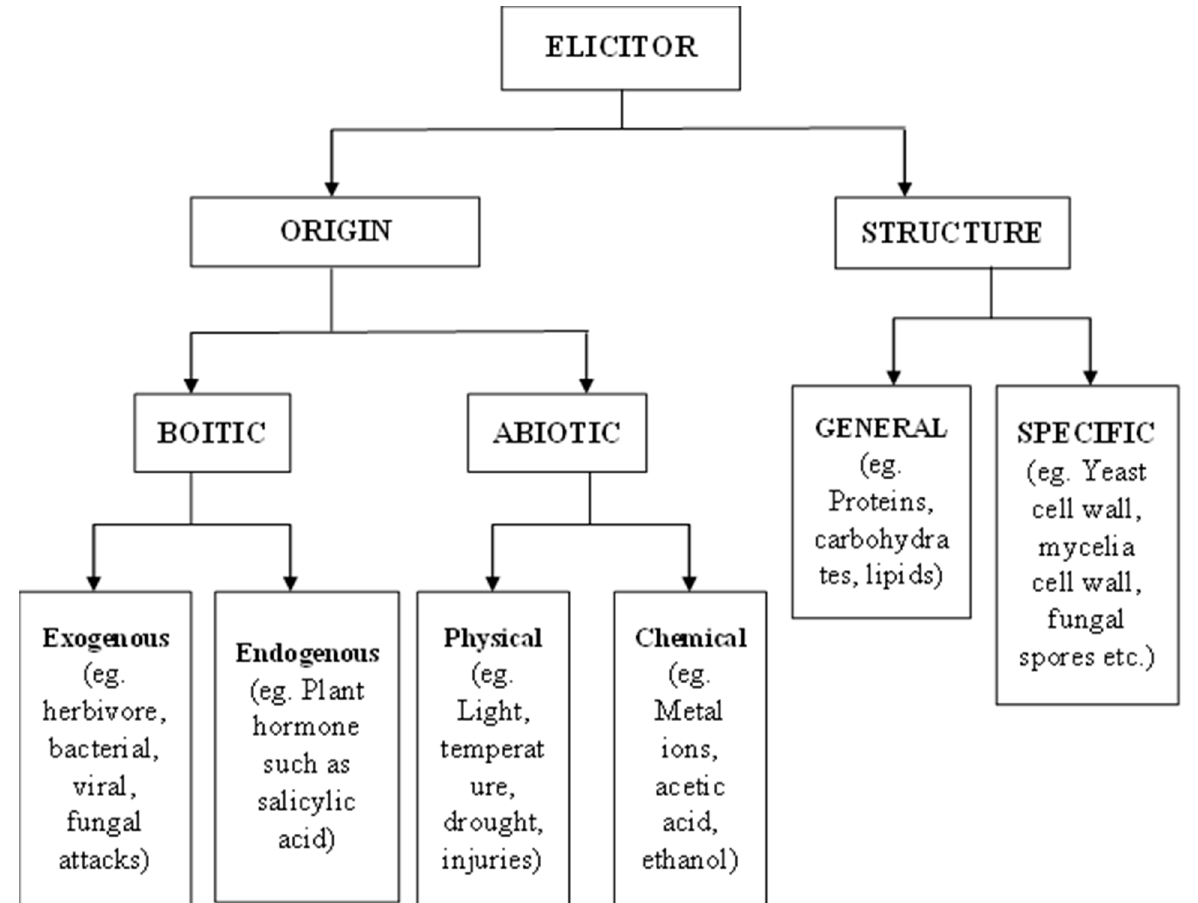
Figure 1. Classifications of elicitors.